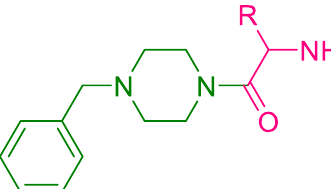
Figure 17. Amino acids conjugated to benzylpiperazine derivatives.